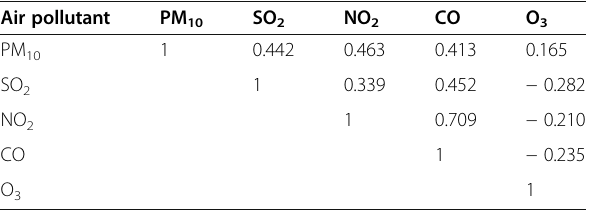
Table 4 Spearman correlation coefficients for the estimates of ambient air pollutant concentrations